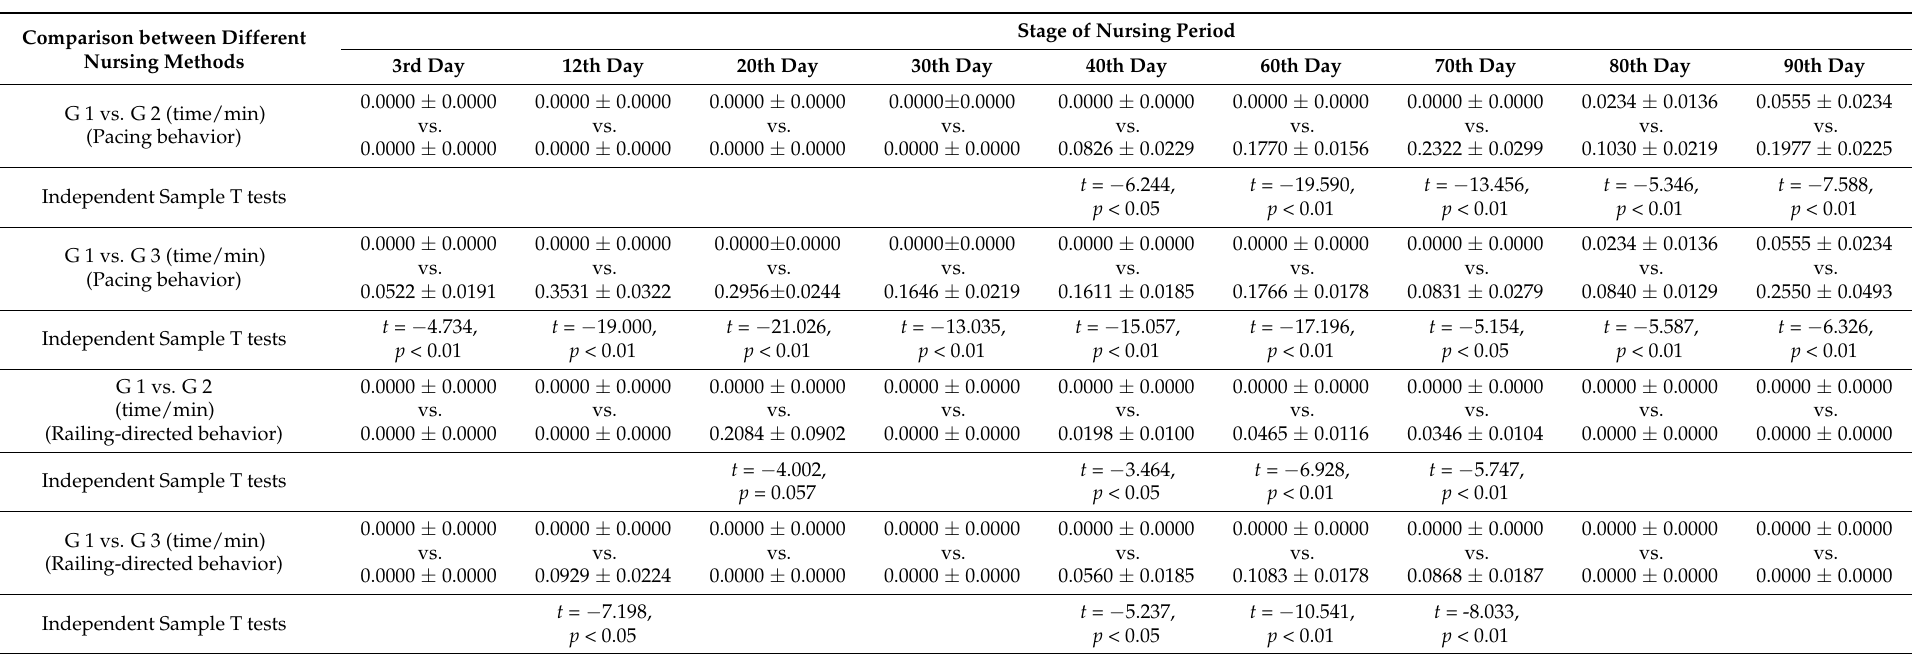
Table 5. Comparison of stereotypic behavioral response of different nursing group panda mothers during the different stages of